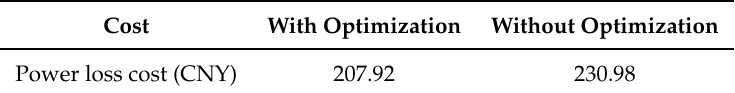
Figure 25. Power loss cost comparison between with and without optimization of the power loss in Scenario 2. Table 7. Total power loss cost comparison between with and without optimization of the power loss cost in Scenario 2.